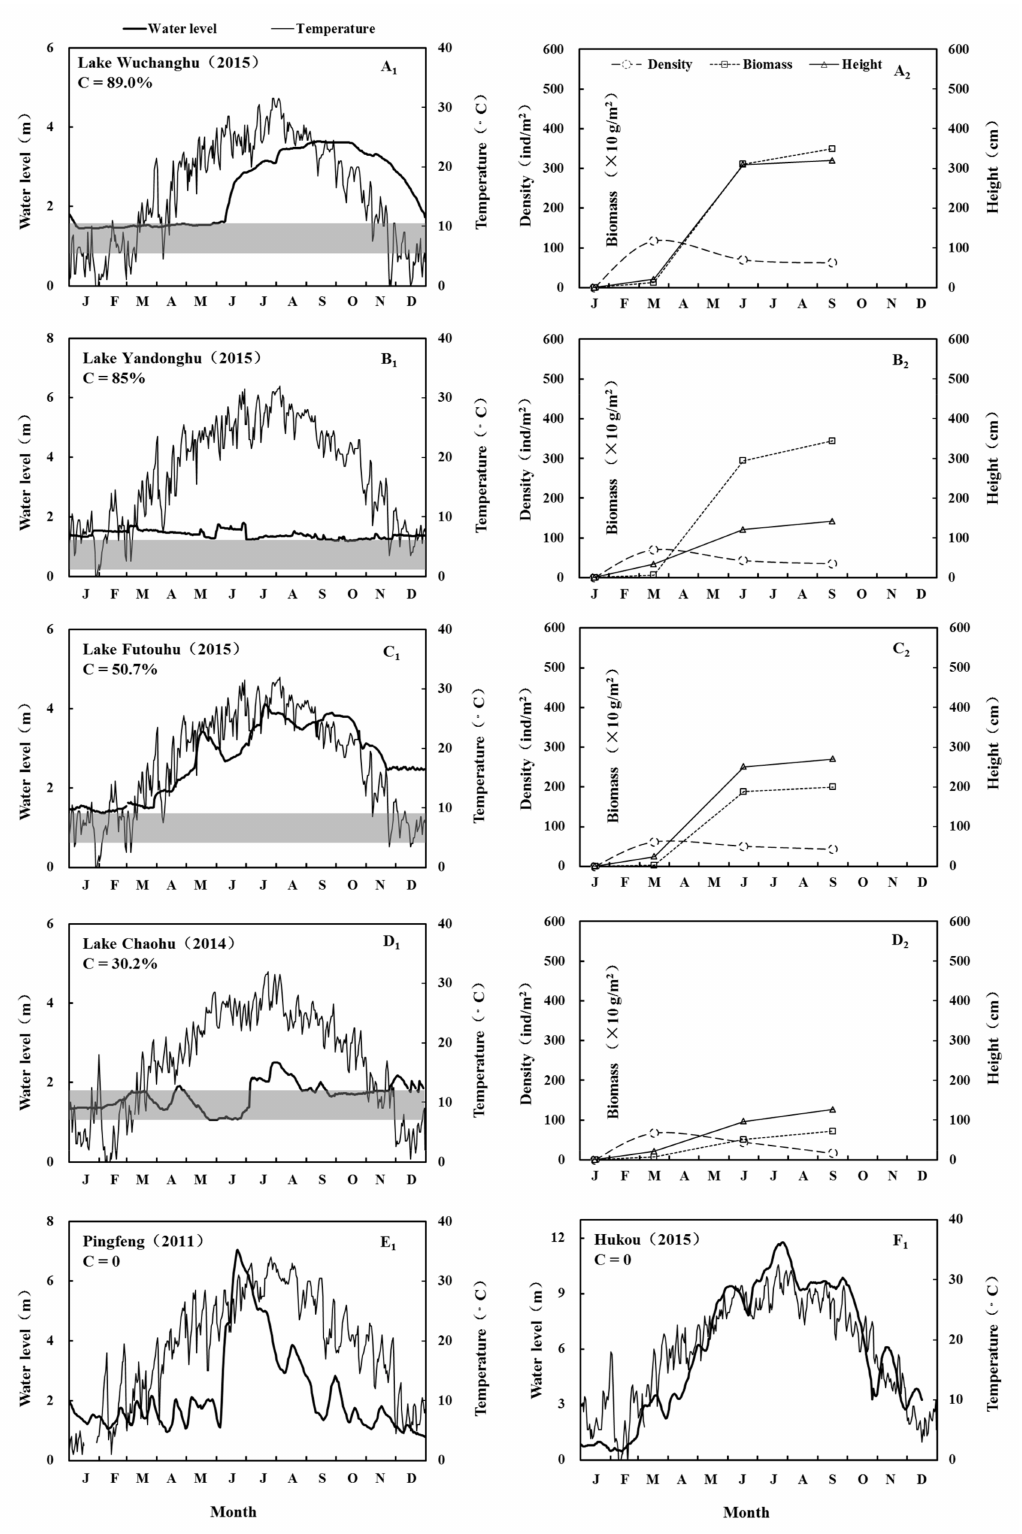
Figure 2. Relationships between the distribution elevation, coverage of Typha and annual water level and temperature and seasonal changes in the density, biomass and height of Typha in lakes. ( A 1 – F 1 ): relative water level, air temperature, distribution elevations and coverage of Typha ; ( A 2 – D 2 ): density, biomass, and height of the plant. Water level represents a standardized water level ( = observed water level data–mean water level between Jan and Mar + 1.5 m). C indicates coverage of Typha . The shaded area represents the distribution range of Typha . Biomass indicates fresh